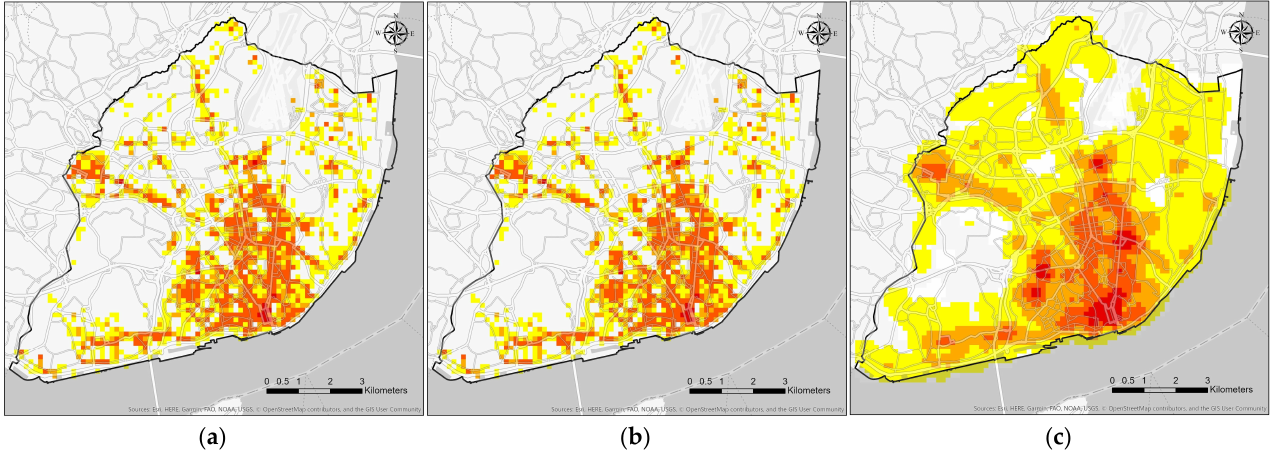
Figure 1. Total Density of Establishments, 1995, using: ( a ) a 150 m-sided square grid; ( b ) a 325 m-sided hexagonal grid; ( c ) the Point Density tool of ArcGIS Pro ® considering a 300 m radius.